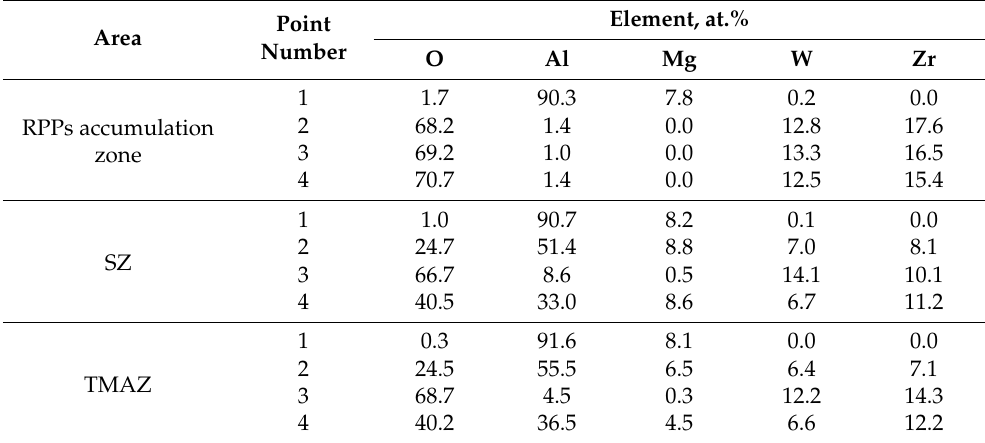
Table 1. Chemical composition (EDS) of an etched section of FSP-ed RPPs/AA 5056 after 4 tool passes.